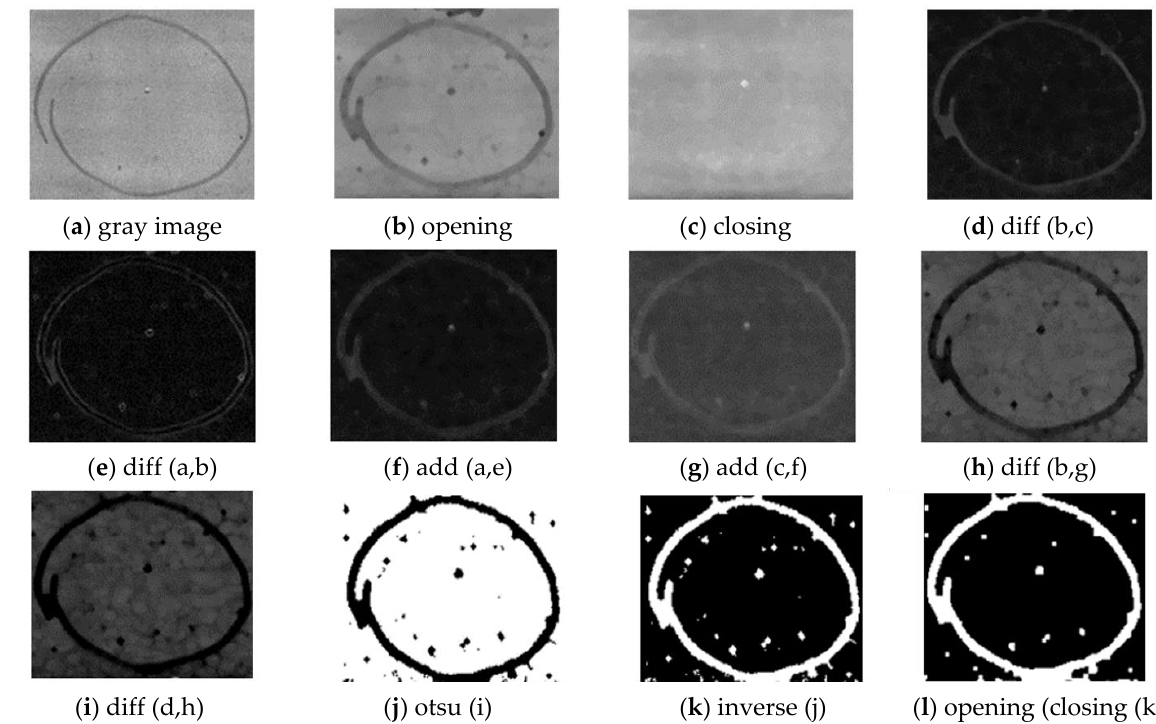
Figure 6. Morphology operation results executed to extract and synthesize multiple feature maps; ( a ) – ( l ). The Otsu algorithm sets the threshold k so that it maximizes the variance 𝜎 B2 (k) among classes in a histogram of the image [13].